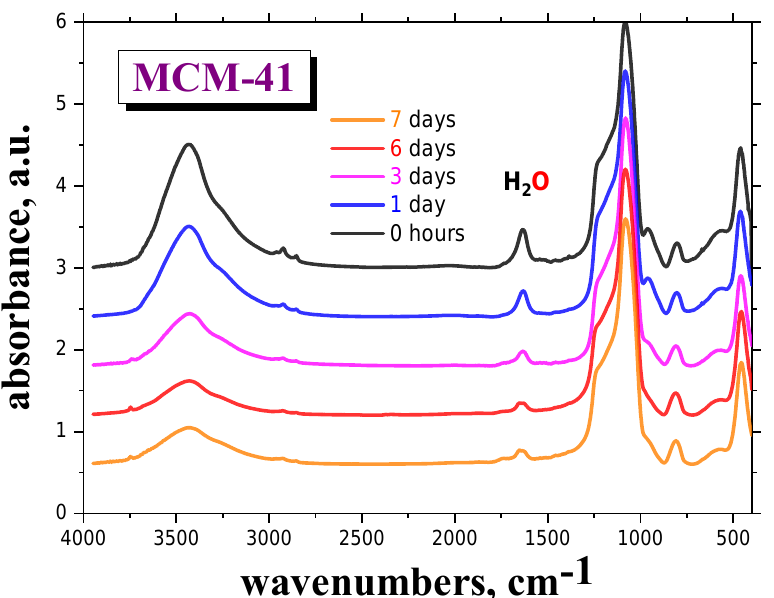
Figure 1. M-IR spectra of the empty MCM-41 dried in the VO at specific drying temperature, T d = 120 °C, for various drying times, t d = 0, 1, 3, 6 and 7 days. Filling the M-IR cell was carried out at RT , under air atmosphere. The peaks at ν ~1630 and ~3500 cm − 1 belong to the bonded H 2 O to the silanol groups of MCM-41 matrix [15,16].